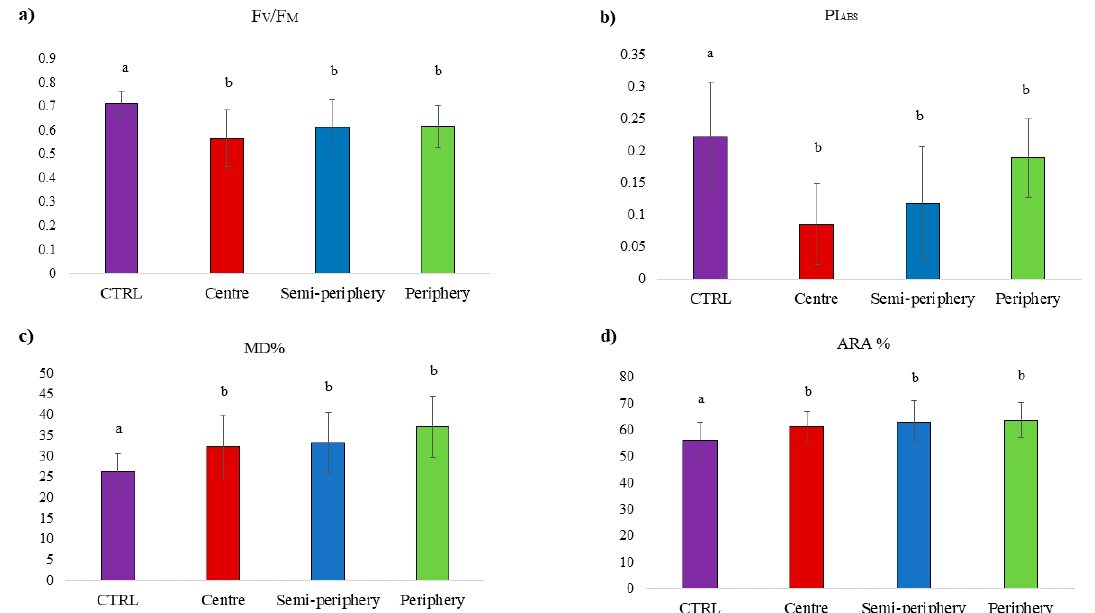
Figure 3. Ecophysiological parameters (mean ± standard error) in control samples (CTRL) and in samples exposed in the three concentric belts. Different letters indicate statistically significant ( p < 0.05) differences. ( a ) Fv/F M , ( b ) PI ABS , ( c ) MD%, and ( d ) ARA%.